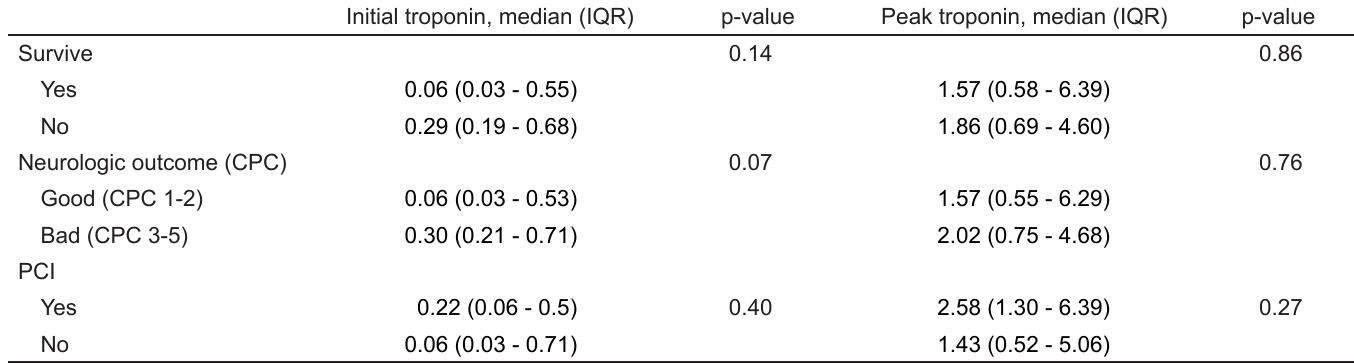
Table 3. Subgroup analysis of patients with cardiac catheterization and without ST segment elevation myocardial infarction (n=85).